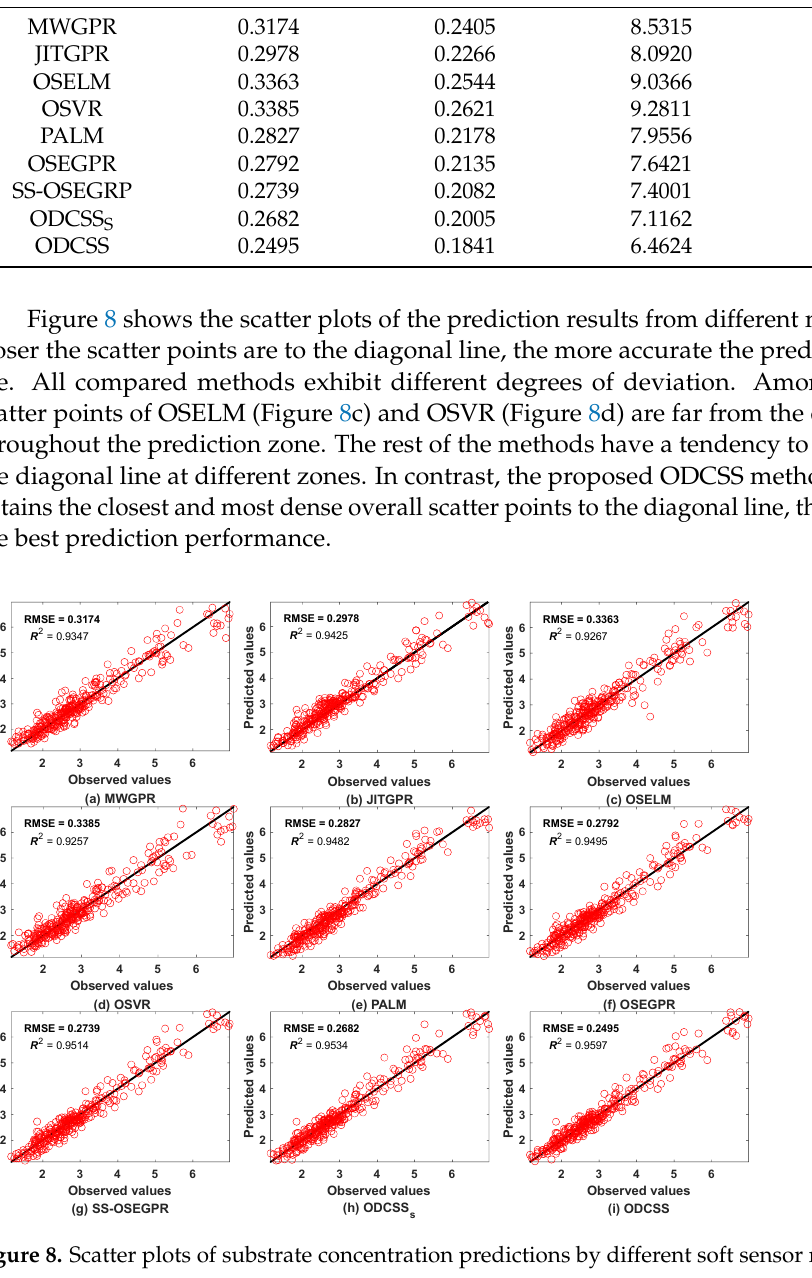
Table 7. Comparison of different soft sensor methods for prediction of substrate concentration in CTC fermentation process.